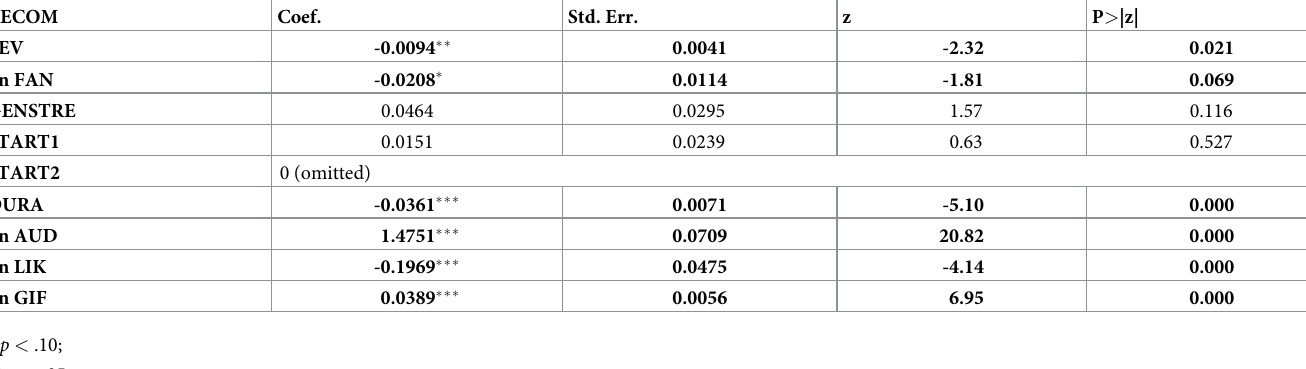
Table 6. Parameter estimates for the Negative Binomial model for game videos ( N = 480). RECOM Coef. Std. Err. z P > |z| LEV -0.0094 �� 0.0041 -2.32 0.021 Ln FAN -0.0208 � 0.0114 -1.81 0.069 GENSTRE 0.0464 0.0295 START1 0.0151 DURA -0.0361 ��� Ln AUD 1.4751 ��� Ln LIK -0.1969 ��� Ln GIF 0.0389